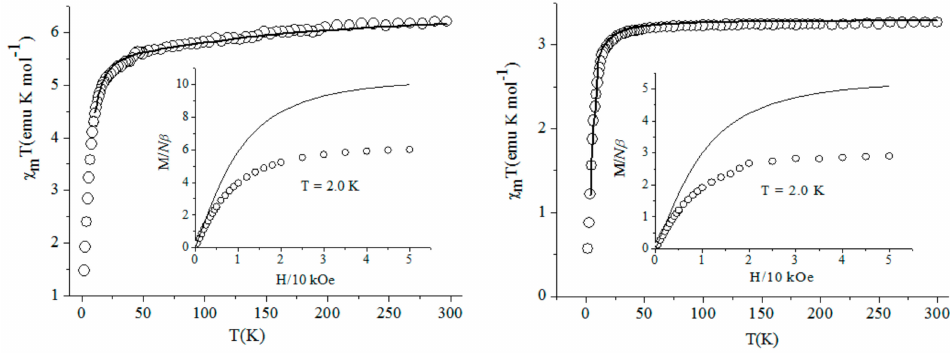
Figure 7. The magnetic property of complexes 2 and 4